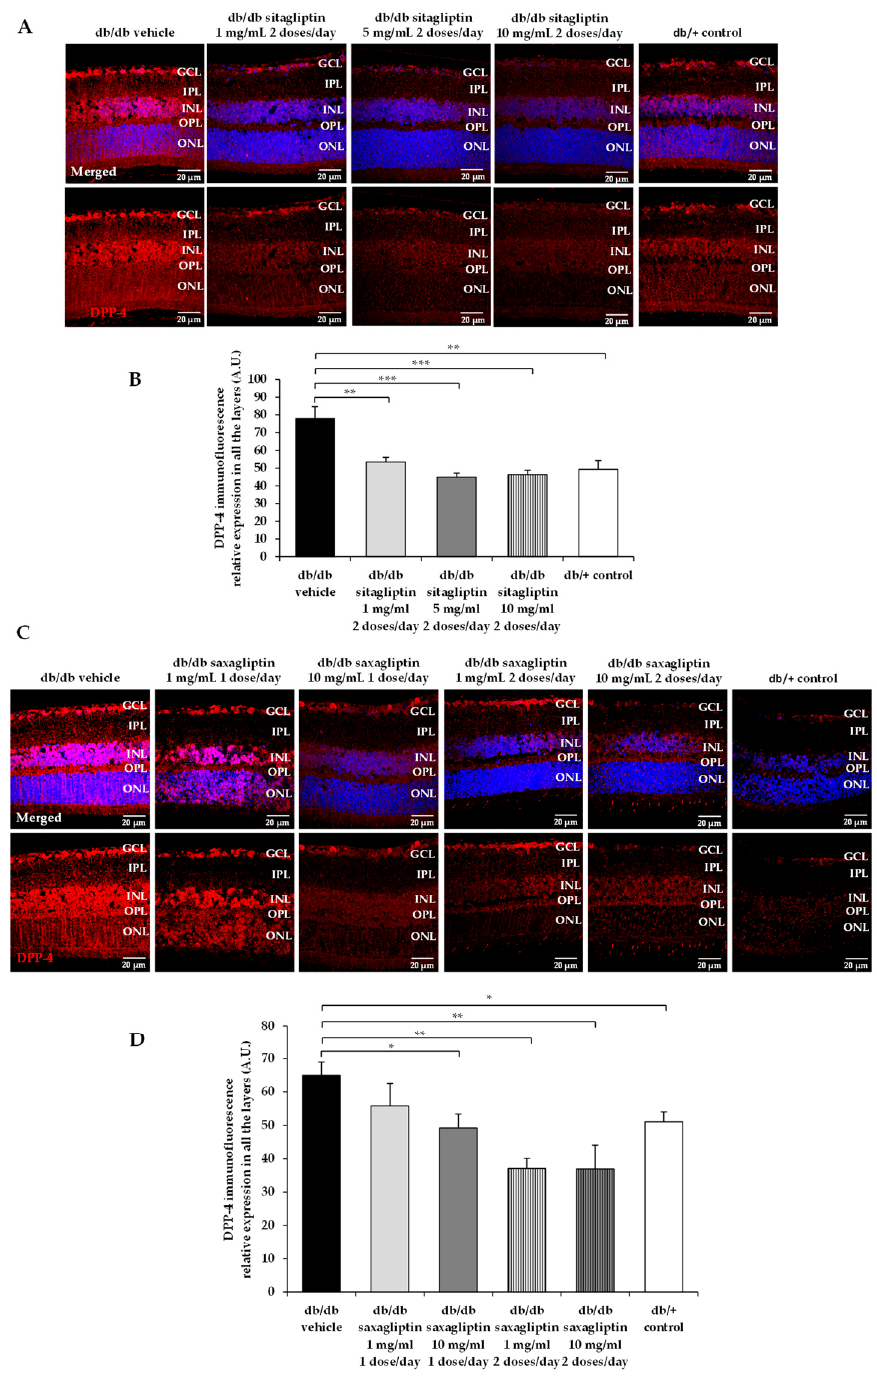
Figure 1. DPP-4 protein abundance. ( A , C ) Comparison of retinal DPP-4 immunofluorescence Figure 1. DPP ‐ 4 protein abundance. ( A , C ) Comparison of retinal DPP ‐ 4 immunofluorescence reac ‐ reactivity (red) among representative samples of each experimental group. DPP-4 relative fluorescence tivity (red) among representative samples of each experimental group. DPP ‐ 4 relative fluorescence intensity is presented alone and merged with Hoechst nuclei staining (blue). ONL: outer nuclear layer; OPL: outer plexiform layer; INL: inner nuclear layer; IPL: inner plexiform layer; GCL: ganglion cell layer. Scale bars, 20 µ m. ( B , D ) Quantification of the DPP-4 immunofluorescence intensity. n = 4 mice per group and 5 retinal sections for each retina. * p < 0.05; ** p < 0.01; *** p <